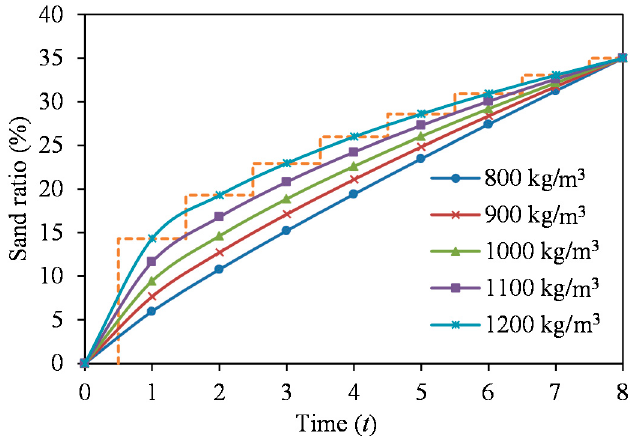
Figure 17. Optimized proppant pumping curves for various desired proppant concentrations. Table 4. Stepped proppant pumping schedule for various desired proppant concentrations.